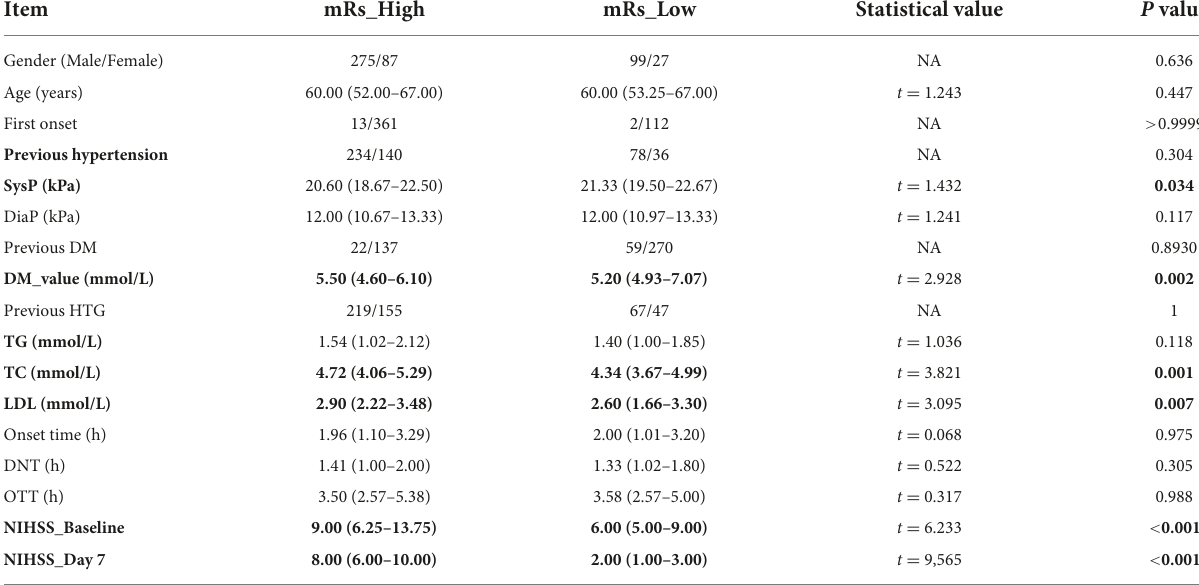
TABLE 1 Clinical data comparison in the in-house